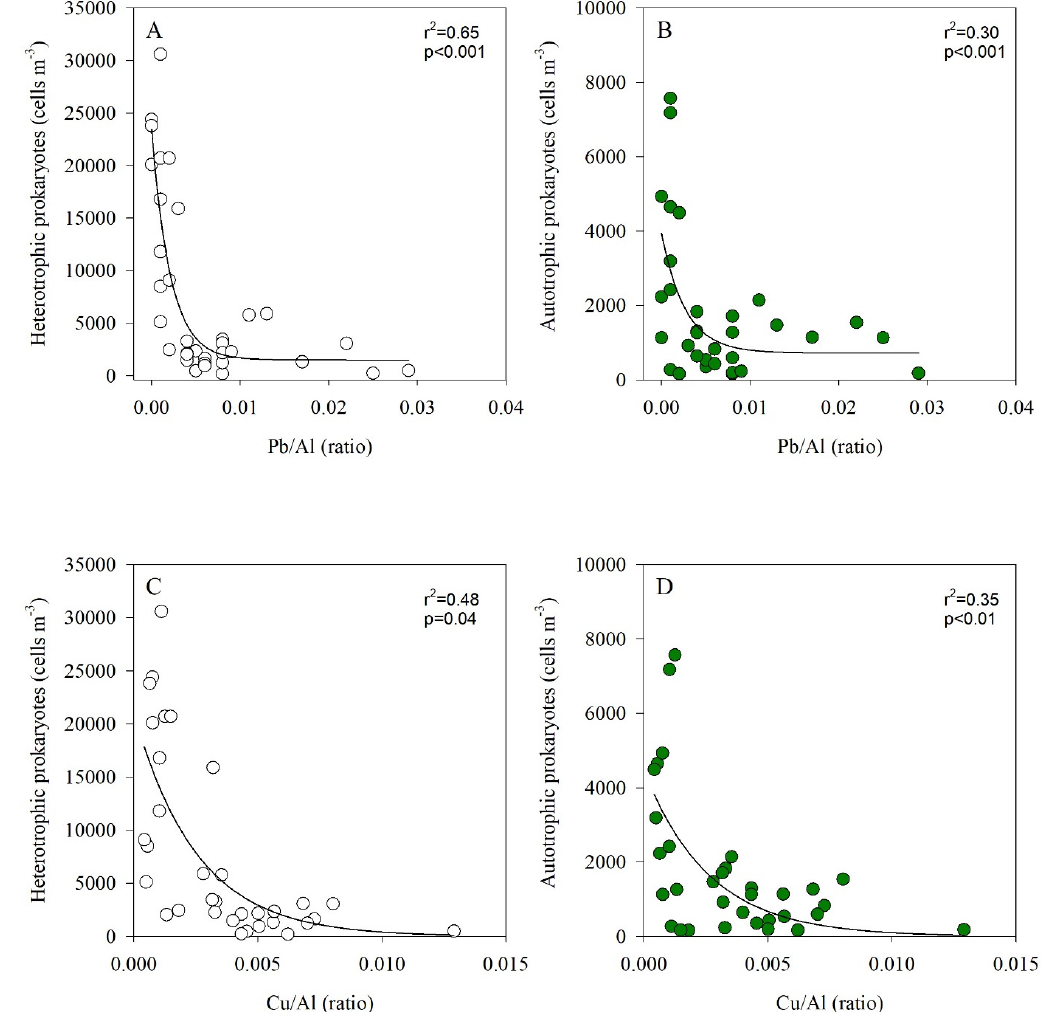
Figure 5. The relationship between the Pb/Al ( A,B ) and Cu/Al ( C,D ) ratios and heterotrophic prokaryotes ( A , C ) and autotrophic prokaryotes ( B , D ) abundance. ( A , C ) and autotrophic prokaryotes ( B , D )